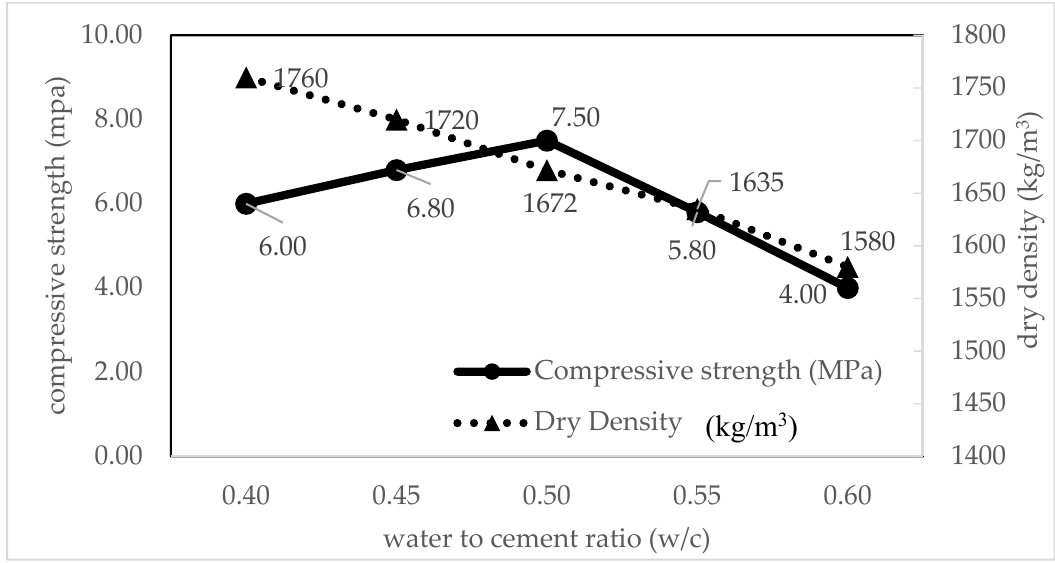
Figure 5. Relationship between compressive strength and density of control FC due to cement ratio.